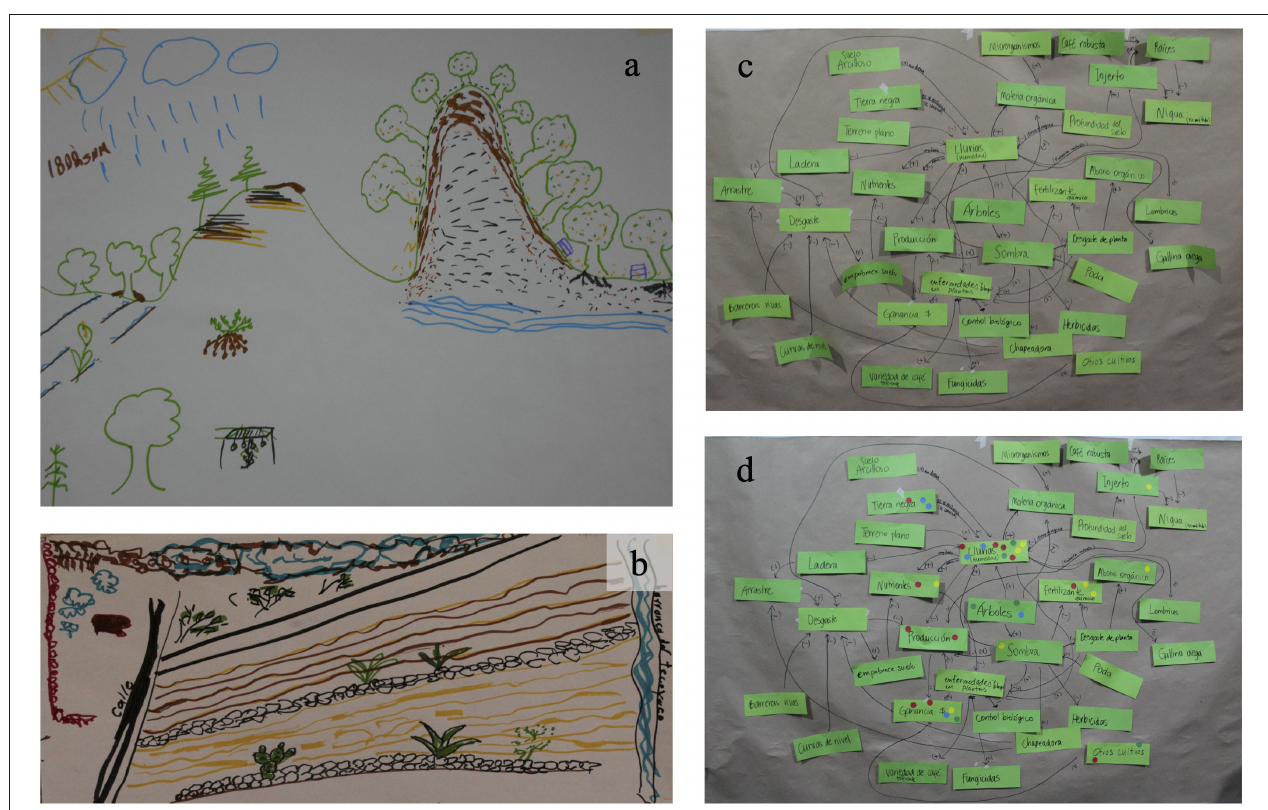
FIGURE 3 | Activities conducted during the focus group. (a) Rich picture drawn at the beginning of a focus group and (b) producers of maize; (c) Group CM built during the focus group with coffee producers, and (d) same group CM depicting weighting scores for the most important concepts according to the participants during the focus